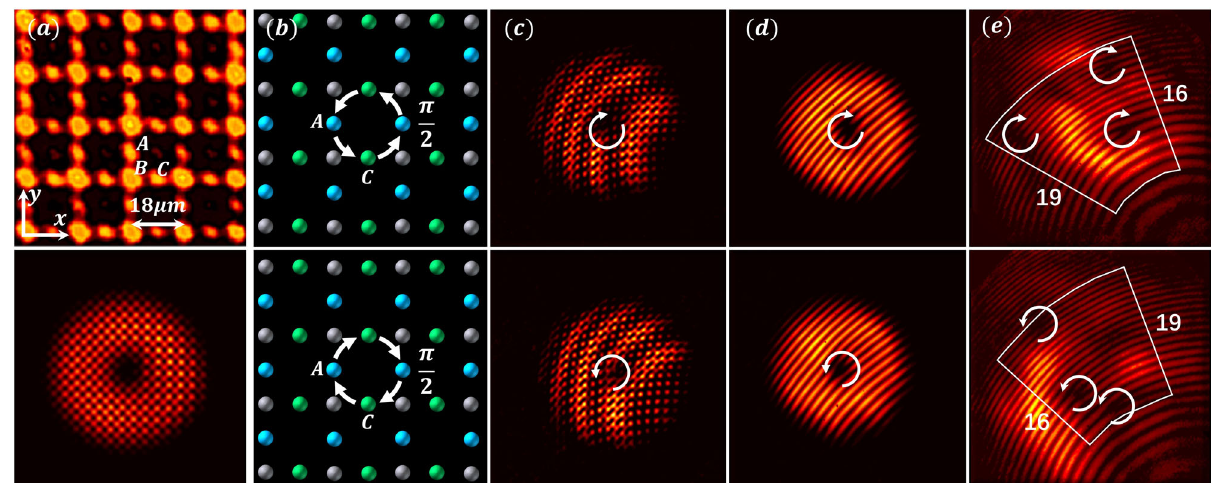
Fig. 4 Experimental demonstration of topological conversion in a pseudospin-1 Lieb lattice. a Top: an optically induced Lieb lattice; Bottom: input pattern of vortex-bearing square lattice beam used to excite the pseudospin states of the Lieb lattice. b Top (bottom) row illustrates selective excitation of A and C sublattices with an appropriate phase relation optimized for pseudospin states s = 1 ( s = − 1) by vortex beams of initial topological charge l = 1 ( l = − 1). c – e Interferograms of input ( c , d ) and output ( e ) showing topological charge conversion from 1 to 3 (top) and from − 1 to − 3